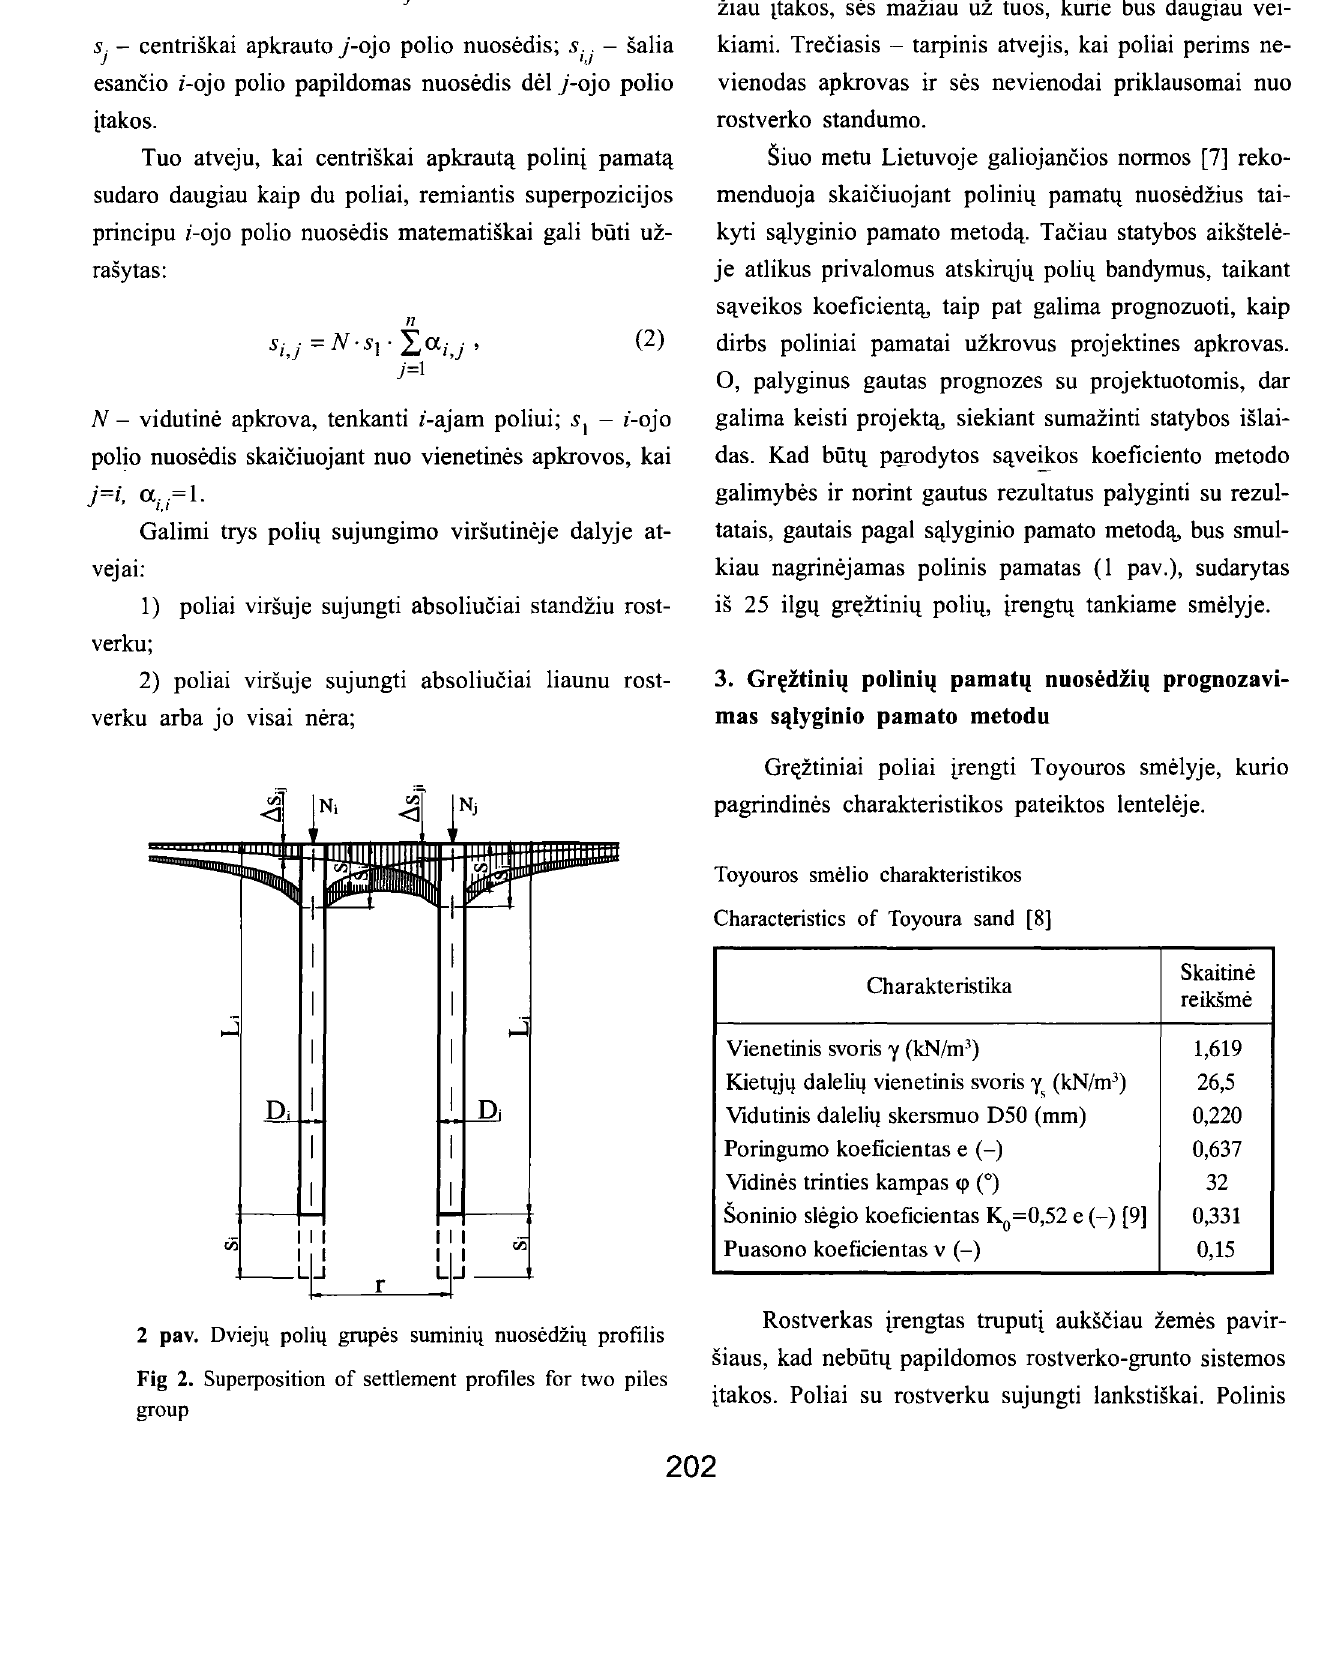
Fig 2. Superposition of settlement profiles for two piles